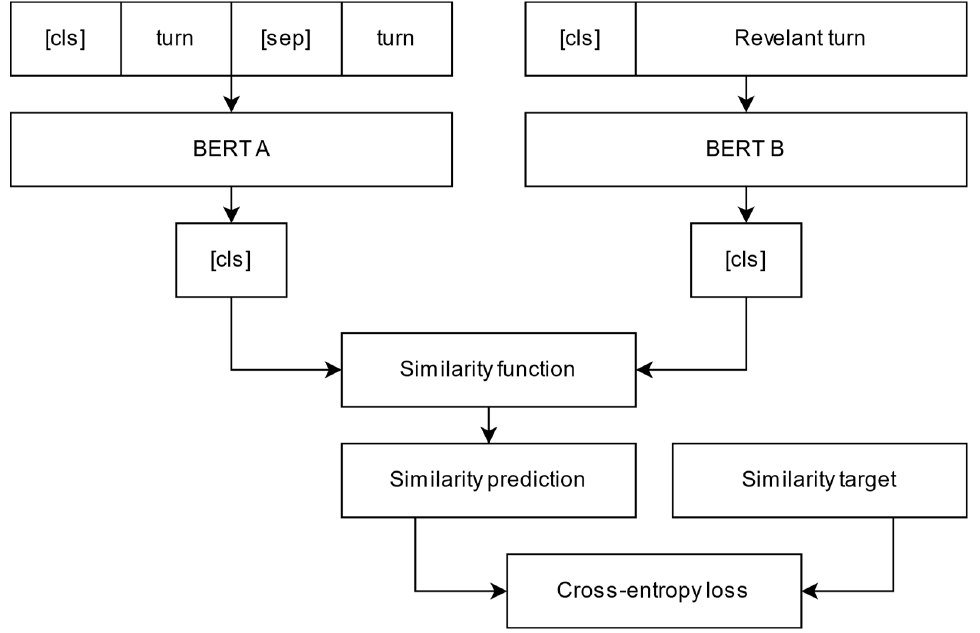
Figure 5. Retrieve and Refine and KG hybrid